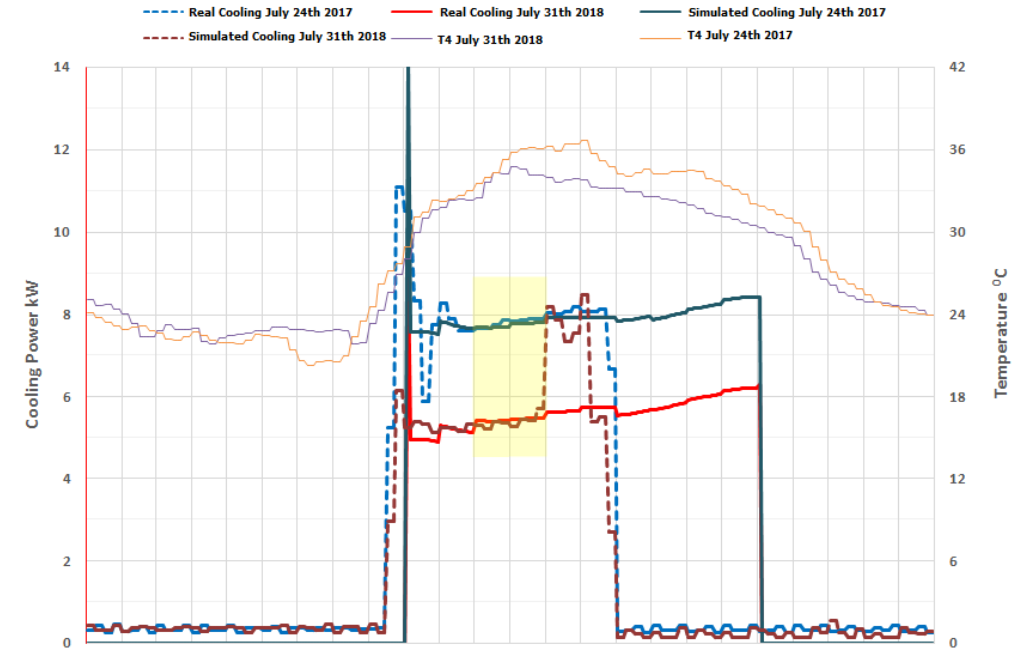
Figure 15. One-day validation of the models for conventional and green roof.